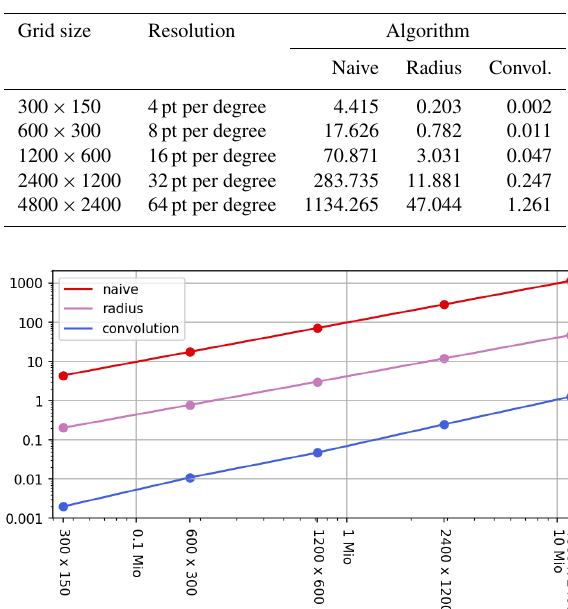
Table 2. Execution times (in s) of the investigated algorithms for varying grid sizes and resolutions, respectively. The number of sam- ple points N = 3490 and the Gaussian width σ = 1 . 0 ◦ are kept con- stant. The convolution algorithm applied a 4-fold convolution.